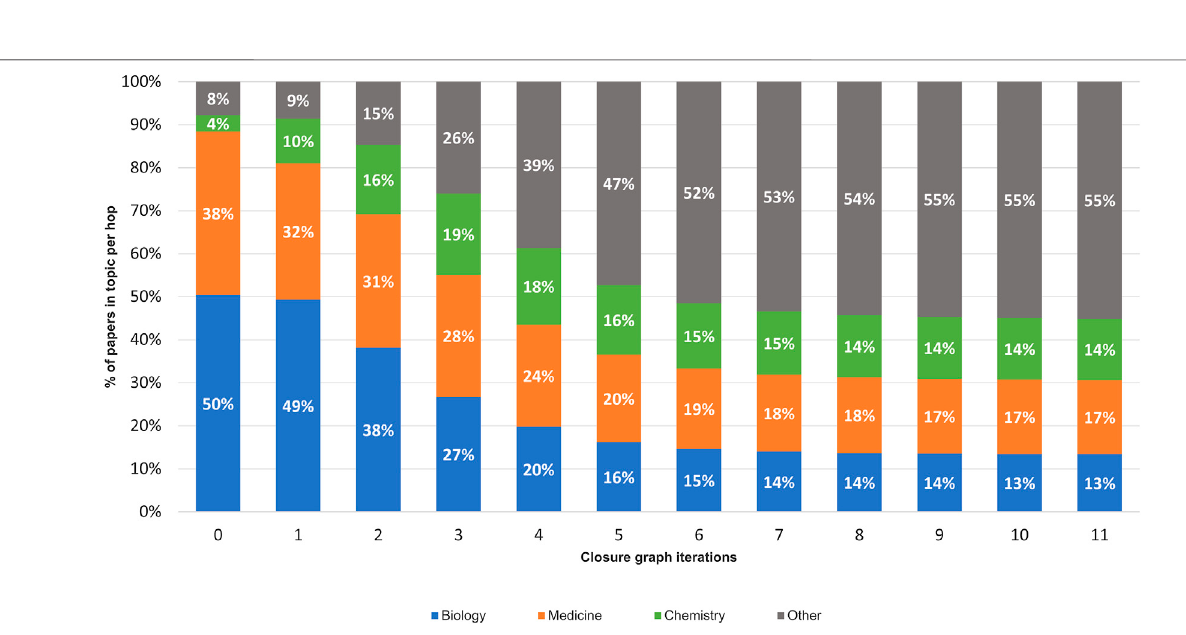
Frontiers in Research Metrics and Analytics |